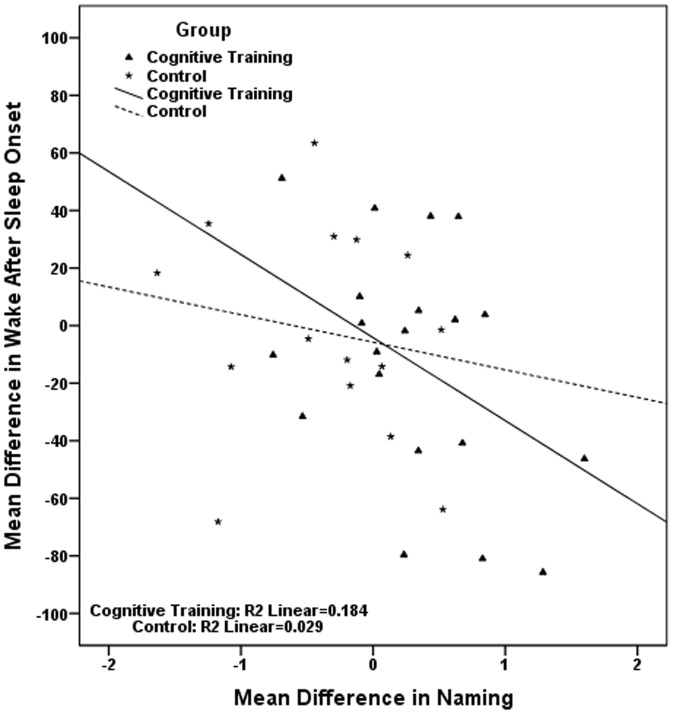
Linear regression between Mean Difference (post-intervention mean minus baseline mean) in Wake after Sleep Onset (dependent) and Mean Difference (post-intervention mean minus baseline mean) in Naming (independent).